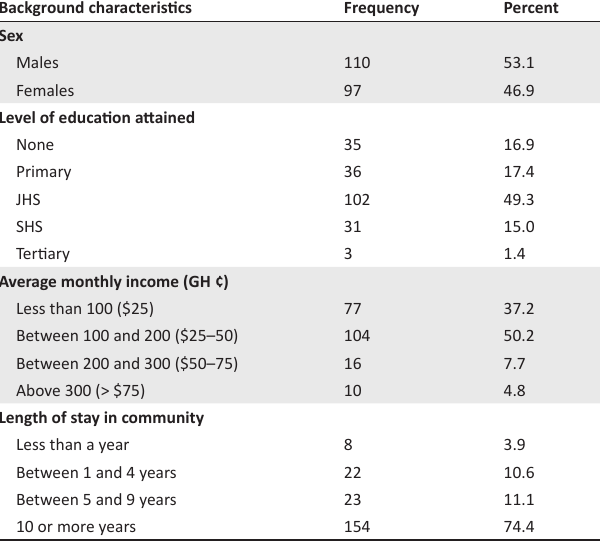
TABLE 1: Background characteristics of